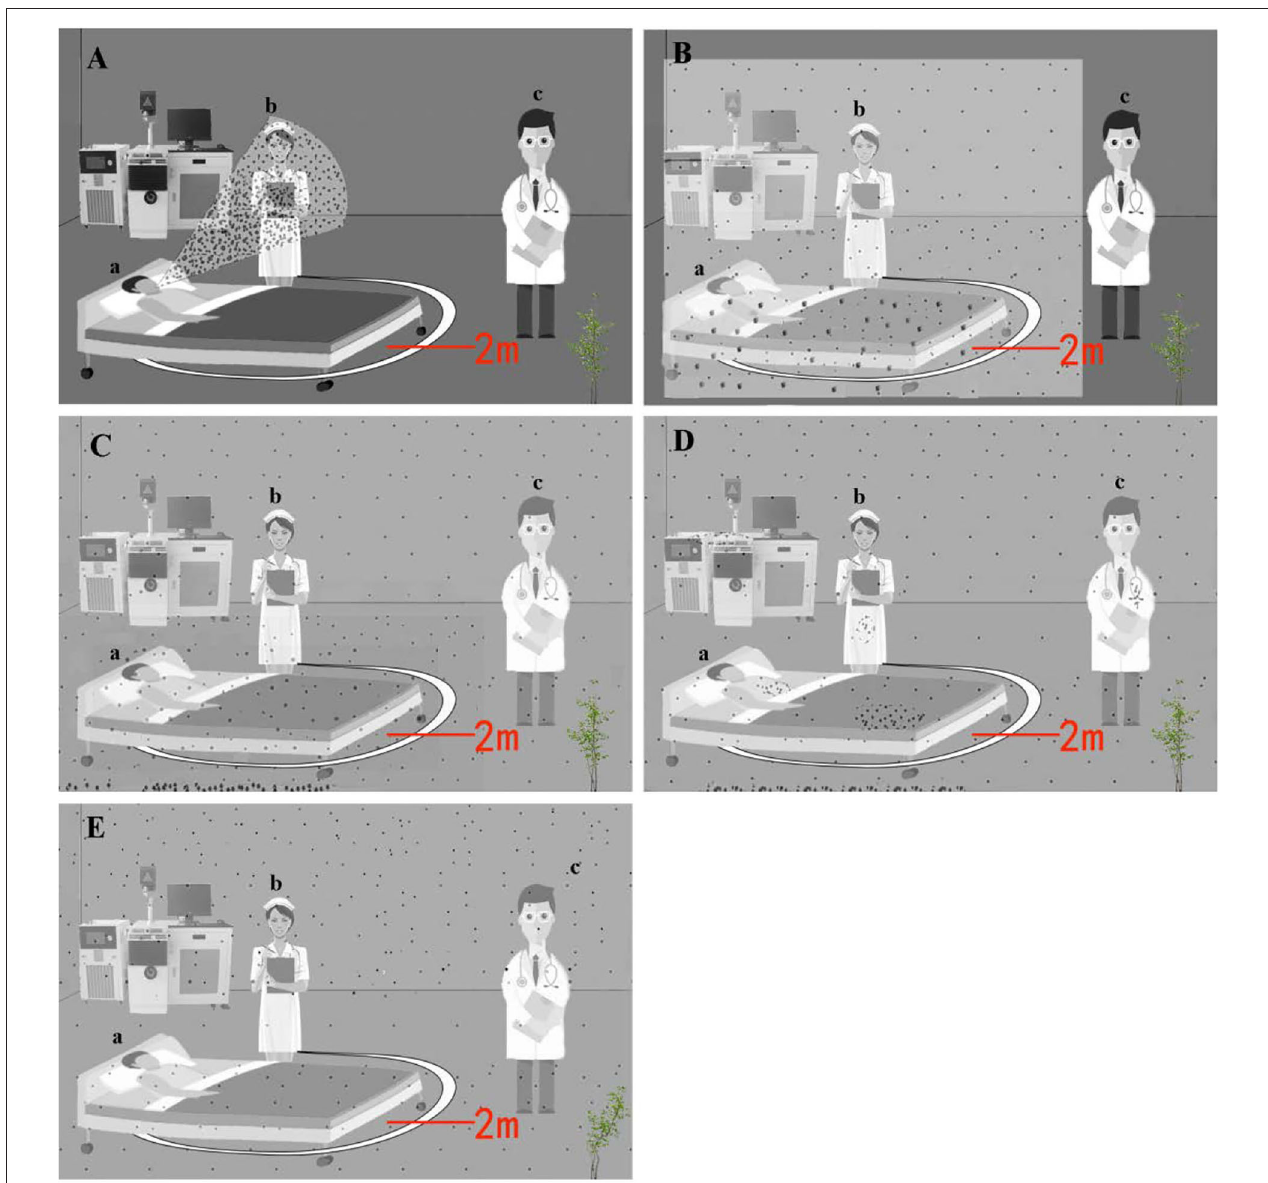
FIGURE 1 | Schematic of aerosol emission, dispersion, and regeneration over time. The larger circles represent droplet, and the smaller circles represent aerosol particles. (A) At time = 0, microbiology aerosol and droplet are generated by patient (a); nurse (b) standing near him is exposed to and inhales a large amount of particles, but the doctor (c) has no exposure. (B) At time = 1, the aerosol is dispersing, and droplets are setting within 2m; nurse inhales particles, and the doctor has no exposure. (C) At time = 2, the aerosol dispersed throughout the ward, and droplets have been deposited on the floor. Nurse and doctor inhale particles. (D) At time = 3, the aerosol particles have deposited on the bed, floor, equipment, etc. (E) At time = 4, airflow or aerosol-generating procedure (AGP) re-aerosolizes the tiny particles that have been